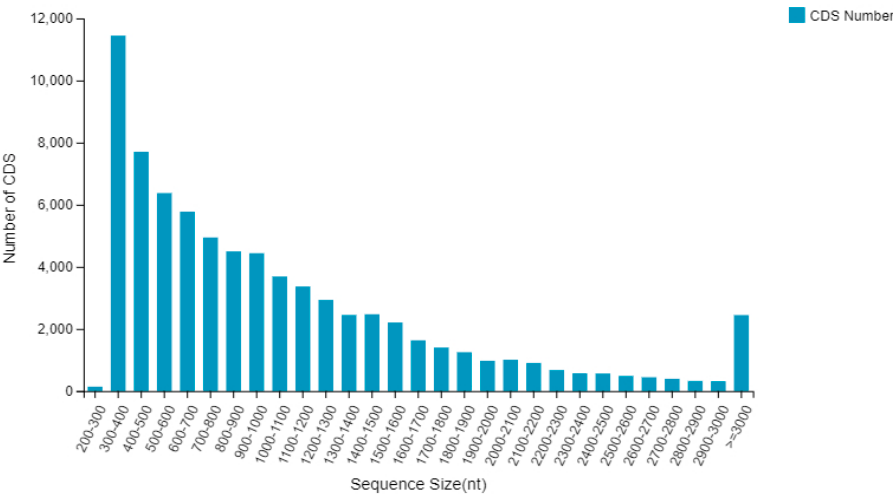
Figure 5. Length distribution of CDS.